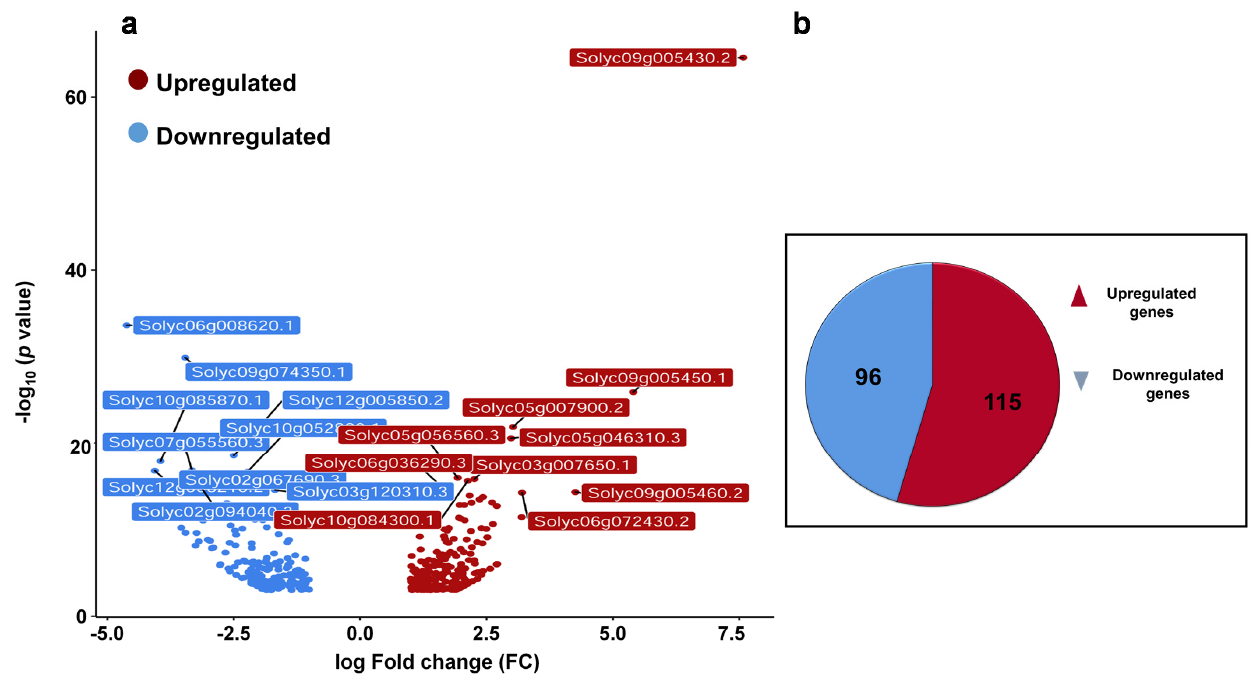
Figure 1. Exogenous application of β CC reprograms transcriptome of tomato plants. Five-week-old tomato plants were treated with β CC or water (control) independently for 4 h, and harvested samples were subjected to RNA sequencing. The obtained transcriptome was tailored with several statistical parameters to get the most differentially expressed genes (DEGs). ( a ) A volcano plot was generated with the 412 DEGs to depict upregulated (red dots) and downregulated (blue dots) genes. Statistically most significant genes are marked with their gene identification (ID) numbers. ( b ) Further filtering of these 412 DEGs, 211 protein-coding DEGs are obtained, out of which 115 DEGs are upregulated (log 2 FC > 1) and 96 are downregulated (log 2 FC < − 1).